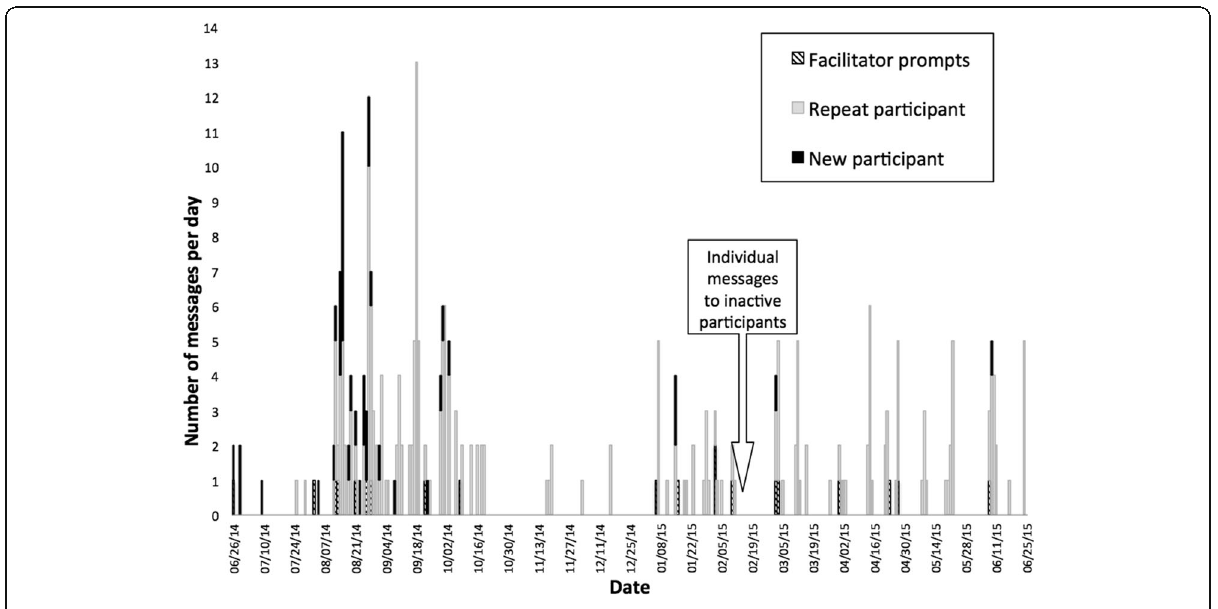
Fig. 5 Chronological frequencies of daily activity on the group email listserv ( n = 46, 35 participants and 11